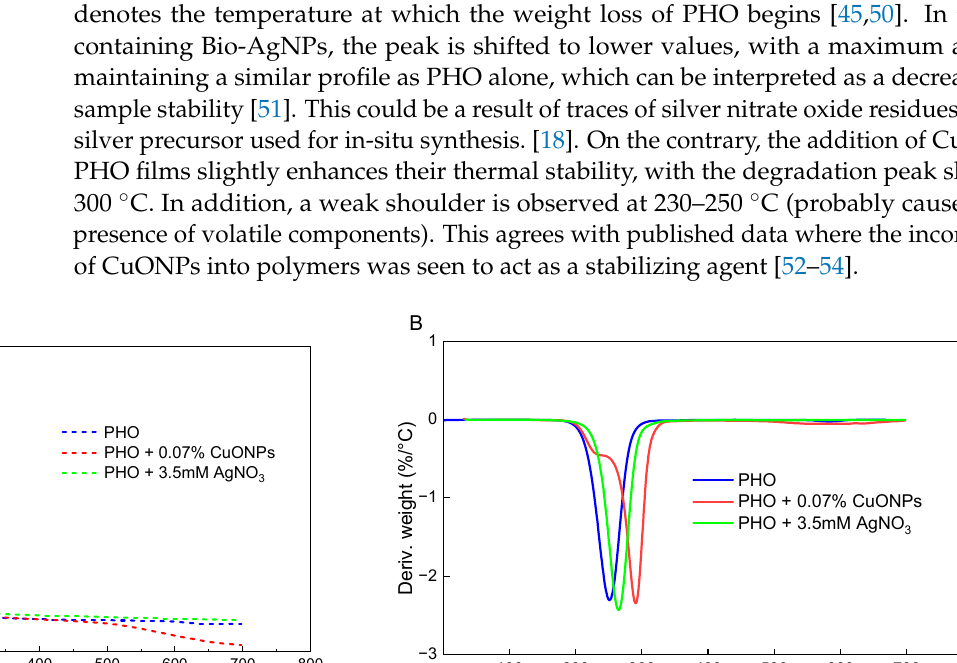
Table 1. Gel permeation chromatography (GPC) of the neat PHO and bioactive films at 35 ◦ C. Samples